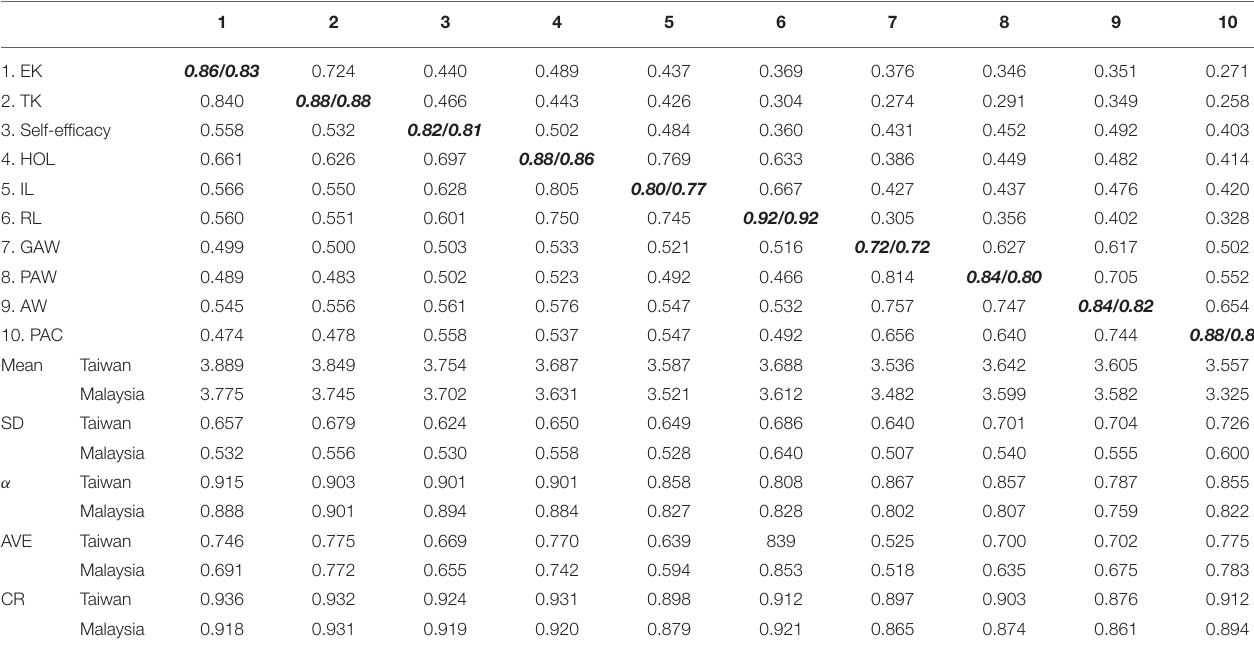
TABLE 3 | Measurement